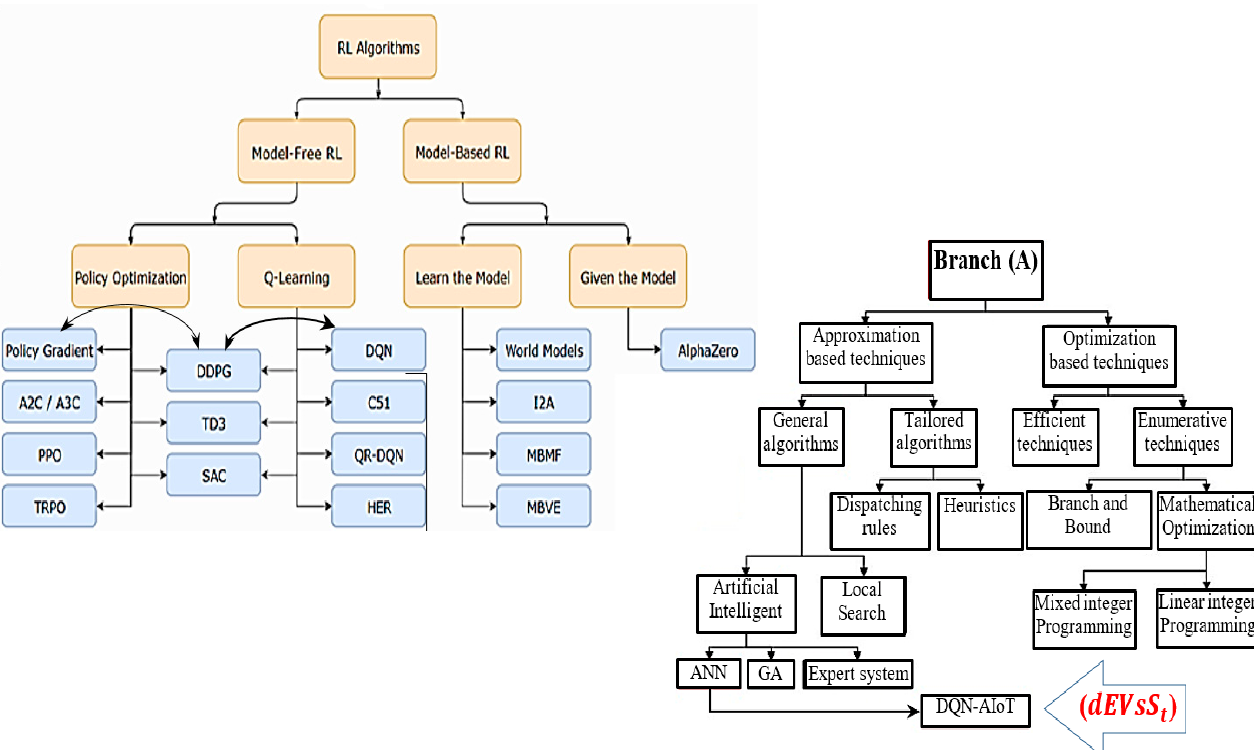
Figure 2. The taxonomy of machine learning models and methodologies.